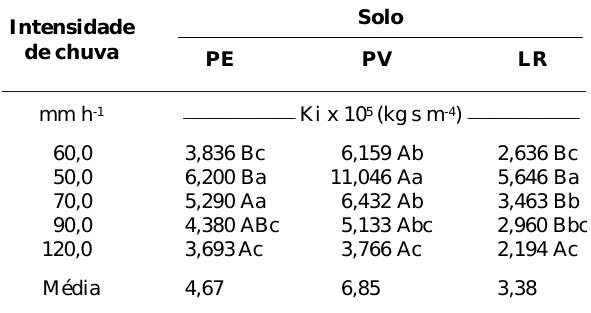
Ki = erodibilidade entressulcos médias em kg s m -4 . Médias se- guidas da mesma letra minúscula, na coluna, e maiúscula, na linha, não diferem significativamente pelo teste de Tukey a 5%.